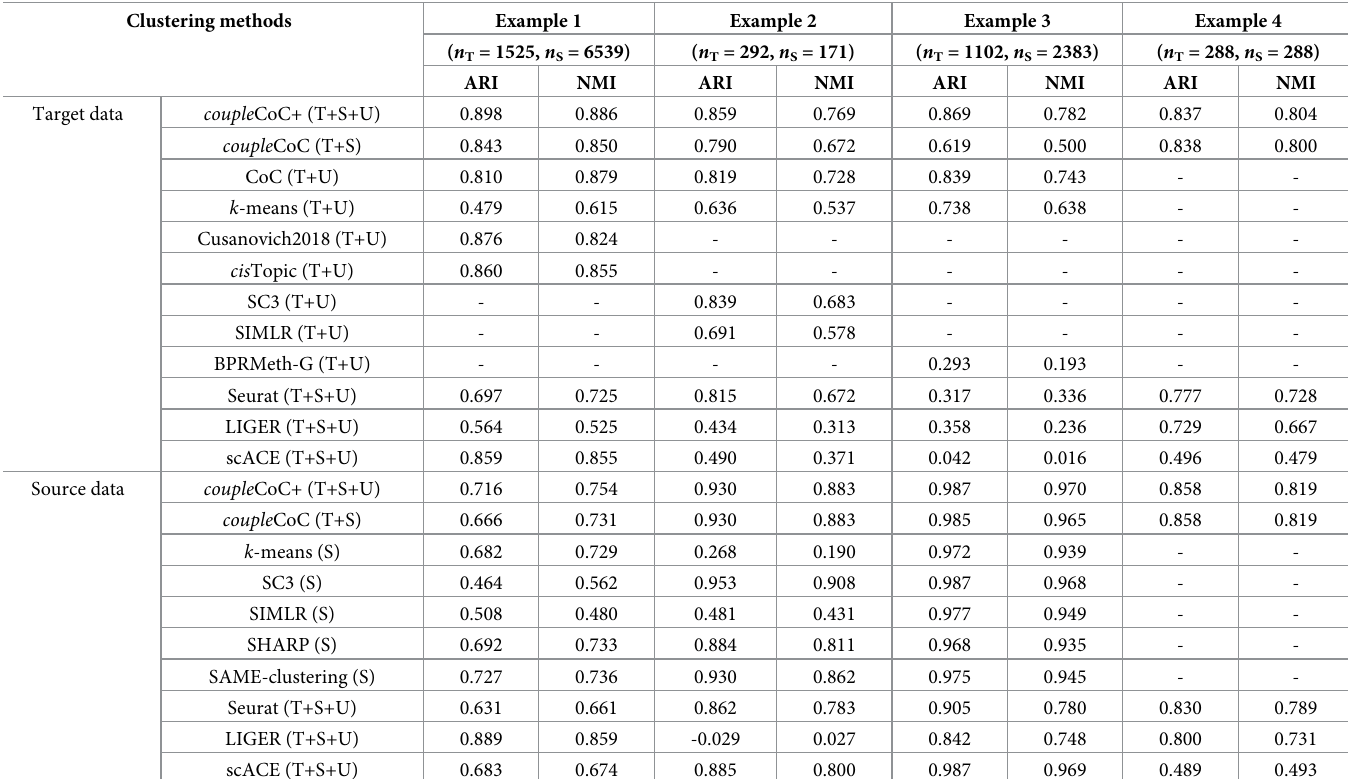
Table 1. The results of clustering the cells in source data and target data in four examples. Note that the capital letters in the brackets represent the input data matrices for the corresponding methods: S represents source data, T and U represent the sub-matrices for the linked and unlinked features in target data, respectively. For integra- tive analysis methods ( couple CoC+, couple CoC, Seurat, LIGER, scACE) that utilize both the source data and the target data as input, they produce clustering results of the cells in source data and target data simultaneously. We then summarize the clustering results by calculating ARI and NMI for source data and target data separately. For the remaining methods that are implemented on only one dataset, they produce clustering results of the cells in source data or target data independently. We then summa- rize the clustering results by calculating ARI and NMI for source data and target data separately. The source data type is scRNA-seq data for all four examples, while the tar- get data types for examples 1–4 are scATAC-seq data, scRNA-seq data, sc-methylation data and scRNA-seq data, respectively. The symbol “-” means that the corresponding clustering method is not designed for that data type. We only compared the methods for integrative analysis of multiple datasets in example 4. n T and n S are the numbers of cells in the target data and the source data, correspondingly. Because we included the unlinked features when implementing CoC, k -means, Cusano- vich2018, cis Topic, SC3, SIMLR and BPRMeth-G, the clustering results for these methods are better than that presented in [42]. Clustering